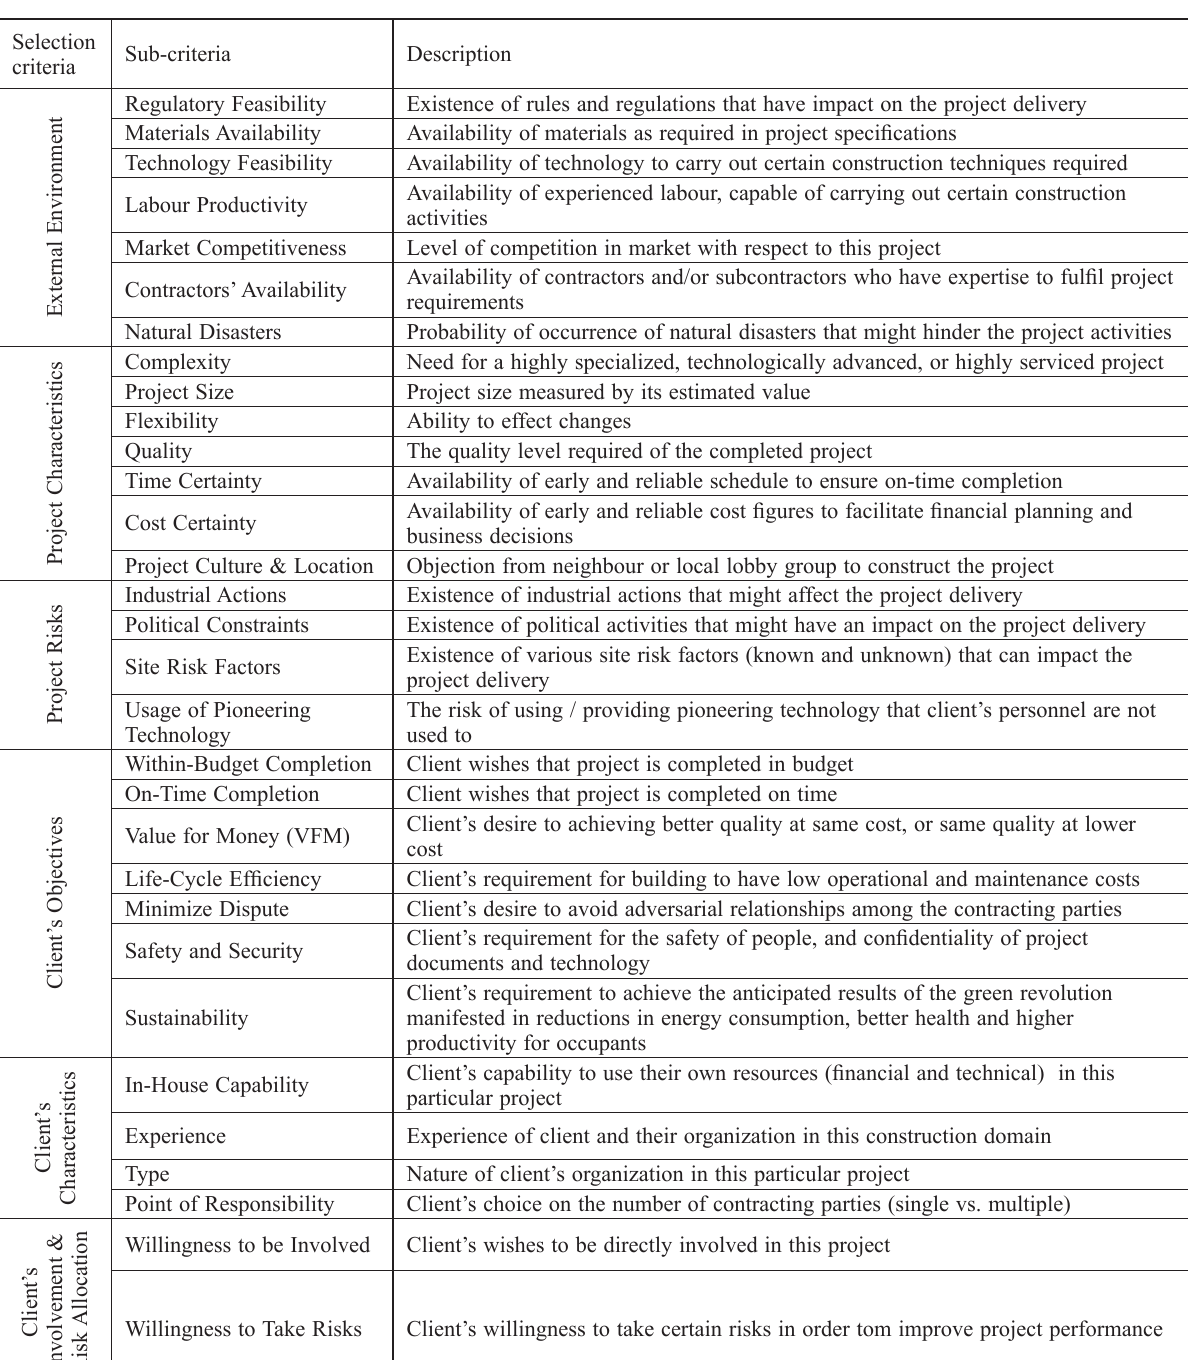
Table 1. Selection criteria and sub-criteria Selection